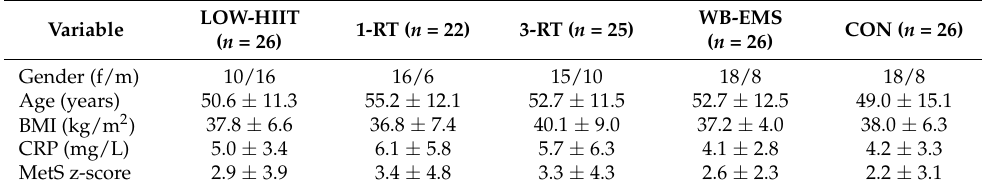
Table 1. Baseline characteristics of all included patients.